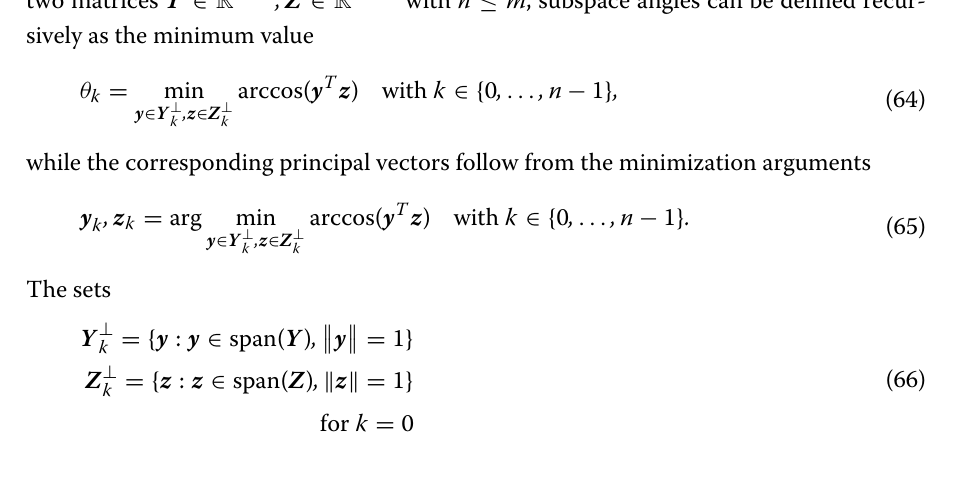
and planes of the parameter domain in order to construct a radial-basis-function approx- imation surrogate. In [46], MMD sampling is used to distribute points in Voronoi cells for multifidelity radial-basis-function metamodeling. Subspace angles for the comparison of